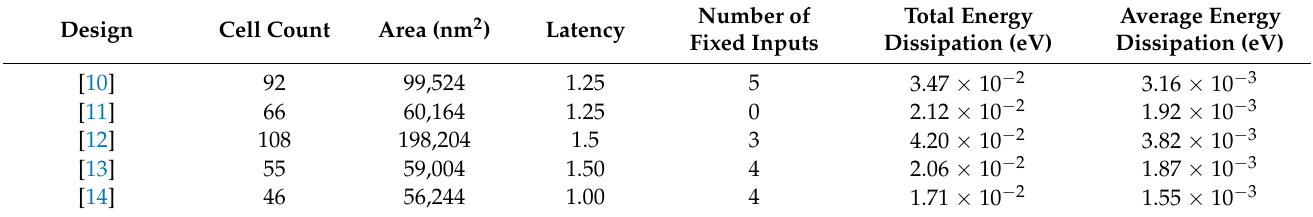
Table 5. Comparisons of the performance and energy dissipation for alternative LST-FFs and NET-FFs.